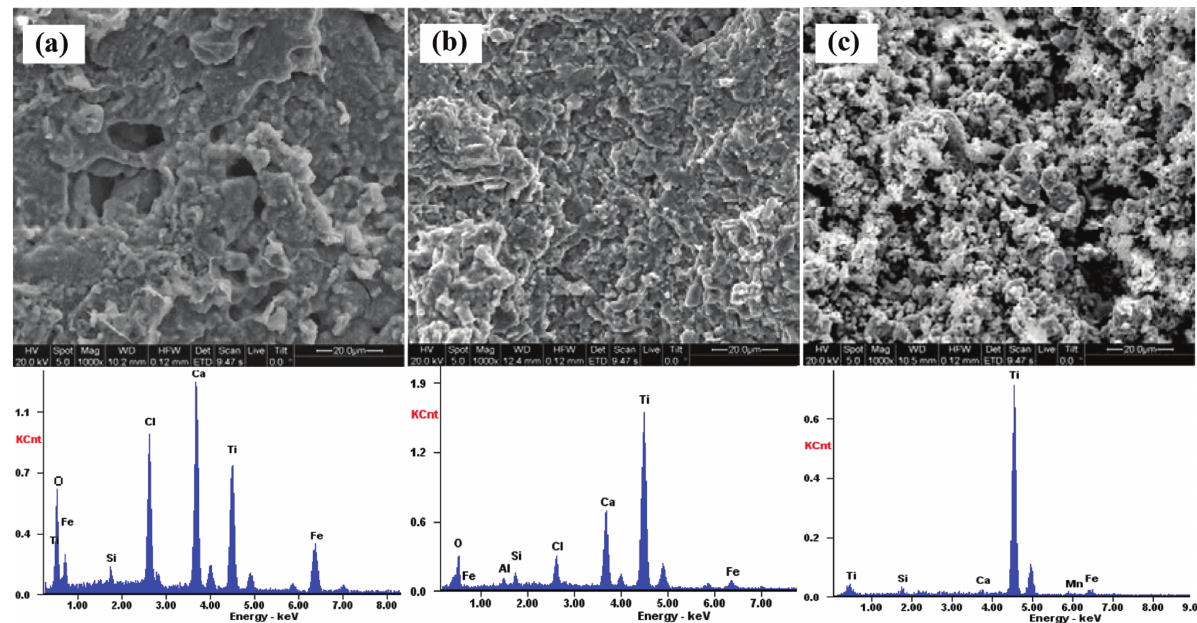
Figure 4: SEM images and EDX spectra of the electrolytic conducts at 1,100 ℃ for different times: (a) 2 h, (b) 4 h and (c) 6 h. Pellets were pressed with 6